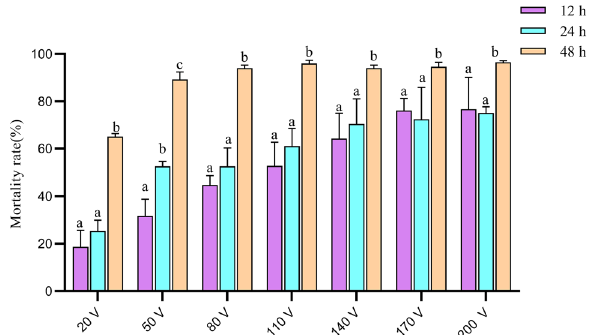
Figure 2. Mortality rate of germinated seeds after treating with DC electrophoresis bath under different voltage and processing times. The error bars stand for standard deviations, and the different letters on the top of the error bars mean significant difference at 5% level.